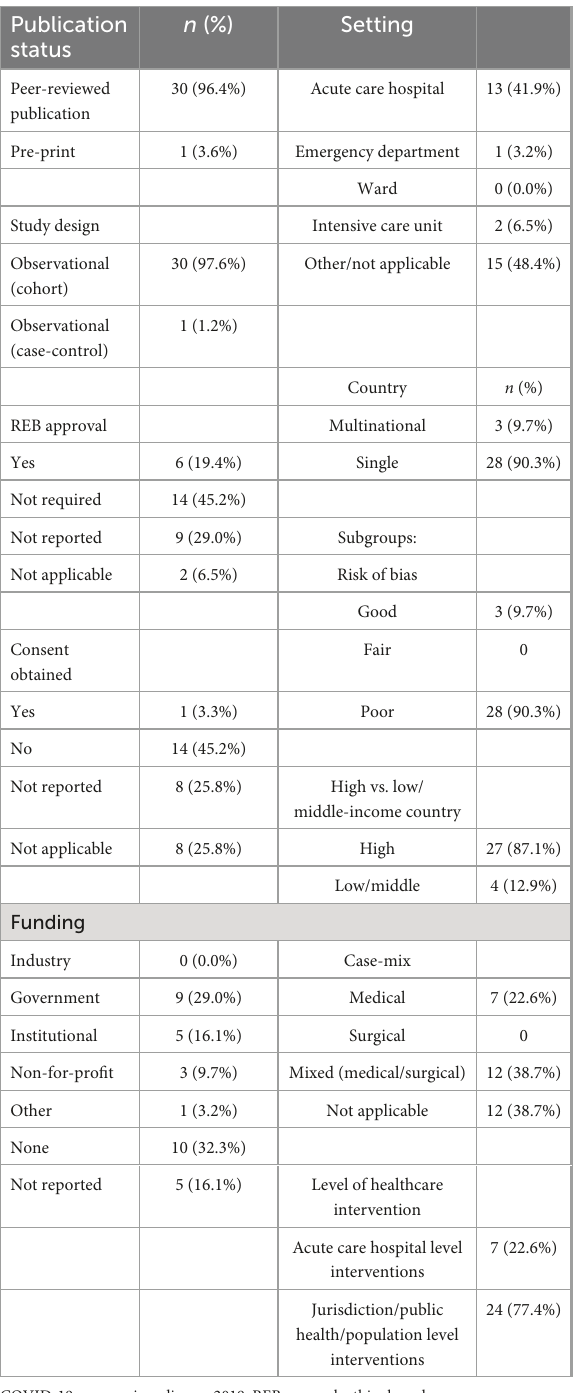
TABLE 1 Summary statistics of study design and characteristics of the studies included in COPES ( n =